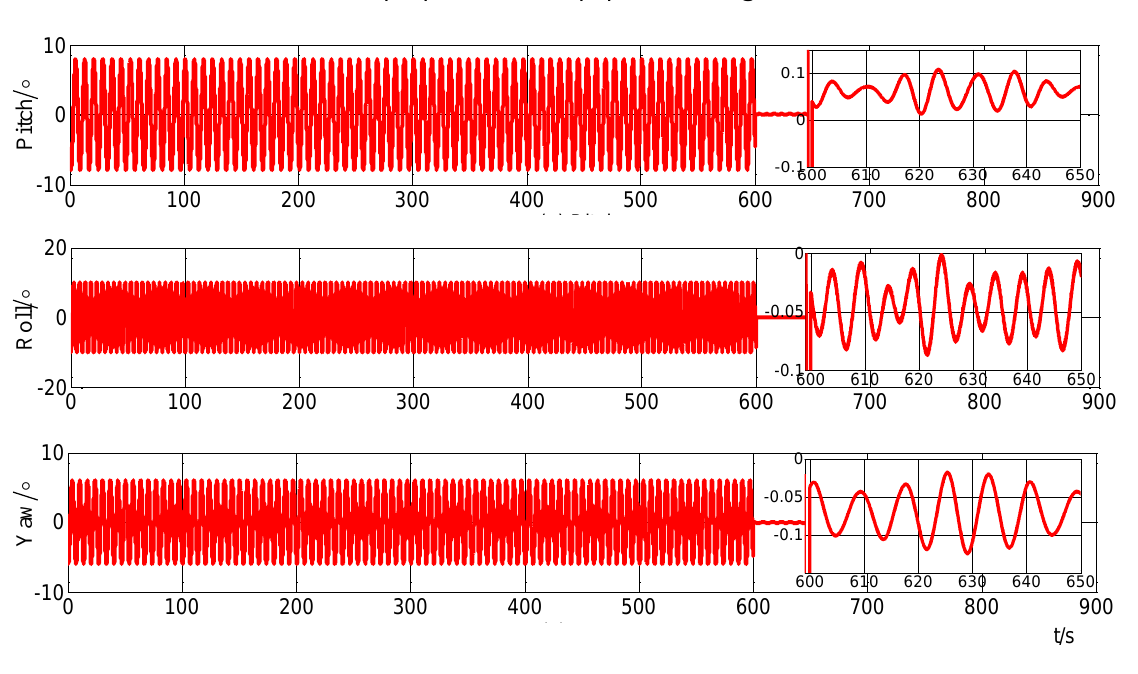
Figure 18. Curves of alignment for the turntable test in